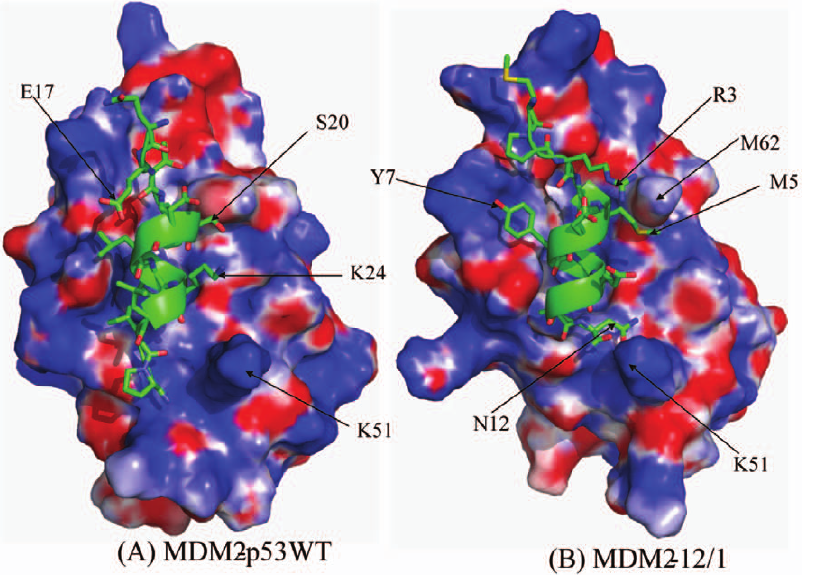
Figure 5. Snapshot showing packing of the p53WT and 12/1 against an electrostatic surface representation of the MDM2. A) Diagram shows the packing of p53WT peptide against an electrostatic surface representation of MDM2 (blue corresponds to positive and red to negative). B) Diagram shows that the 12/1 peptide packs against MDM2 with better electrostatic complementarity.